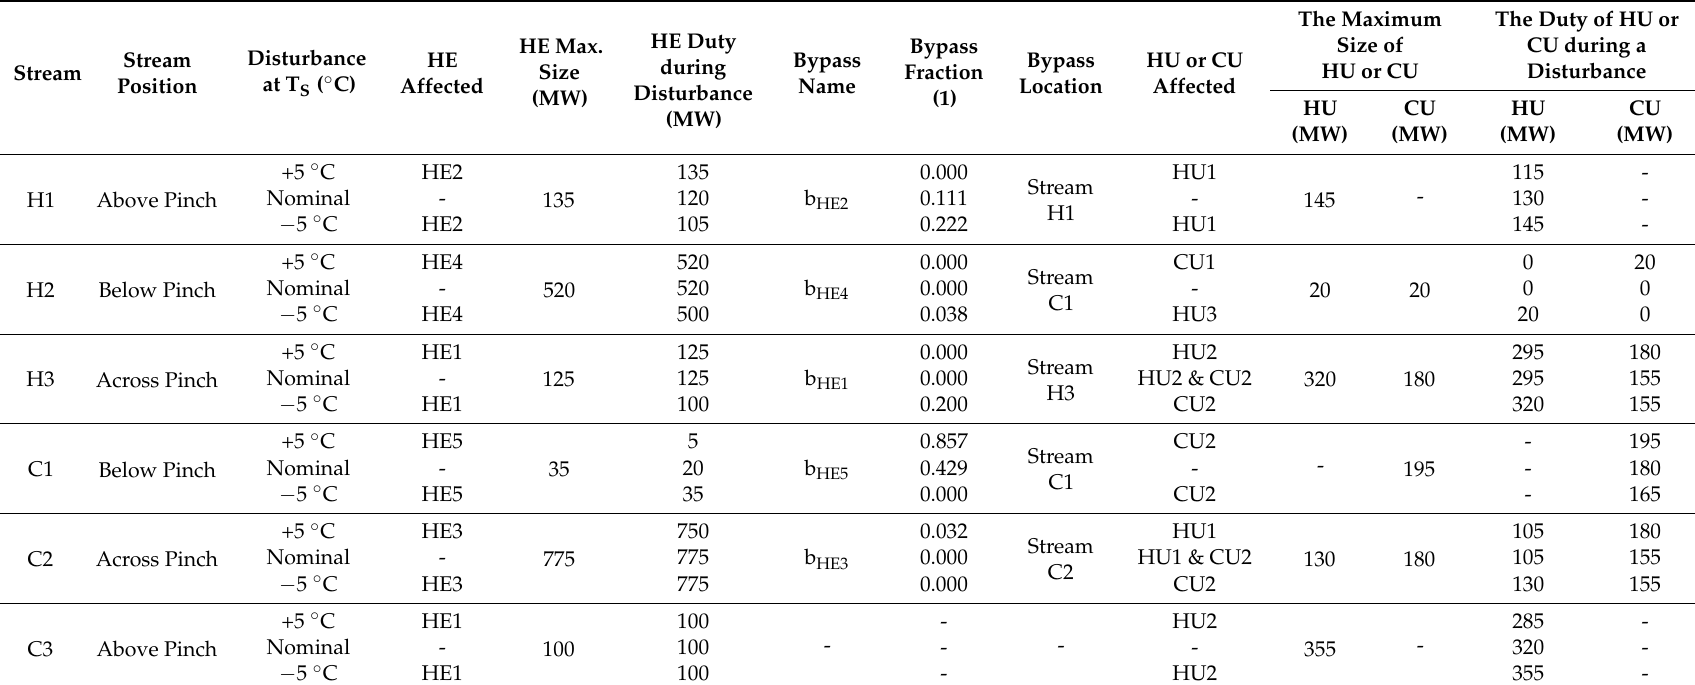
Table 3. Analysis of bypass and utility requirements of HEN